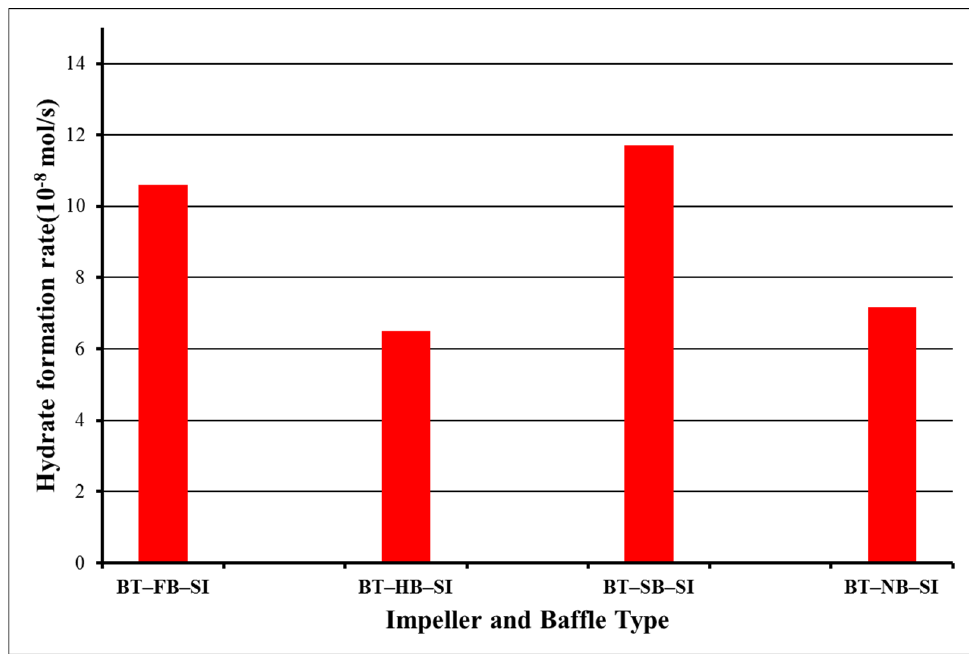
Figure 6. Hydrate formation kinetics values for 10,800 s in single impellers at starting rotation properties of 2 °C and 42.5 bars.